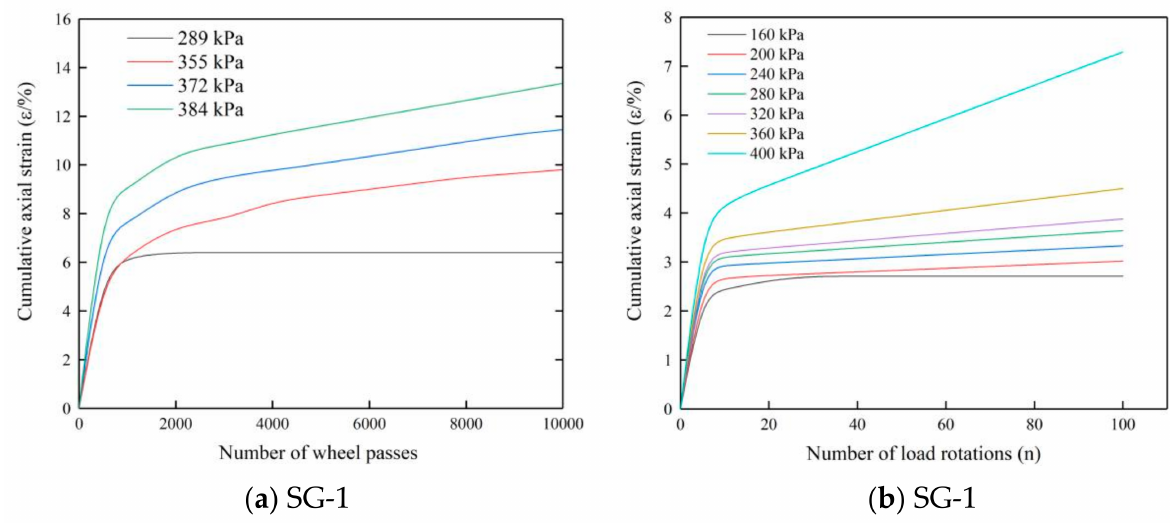
Figure 12. ( a ) Deformation relationship for graded crushed stone mixture under cycling wheel load; ( b ) deformation relationship for graded crushed stone mixture under cyclic rotating axial